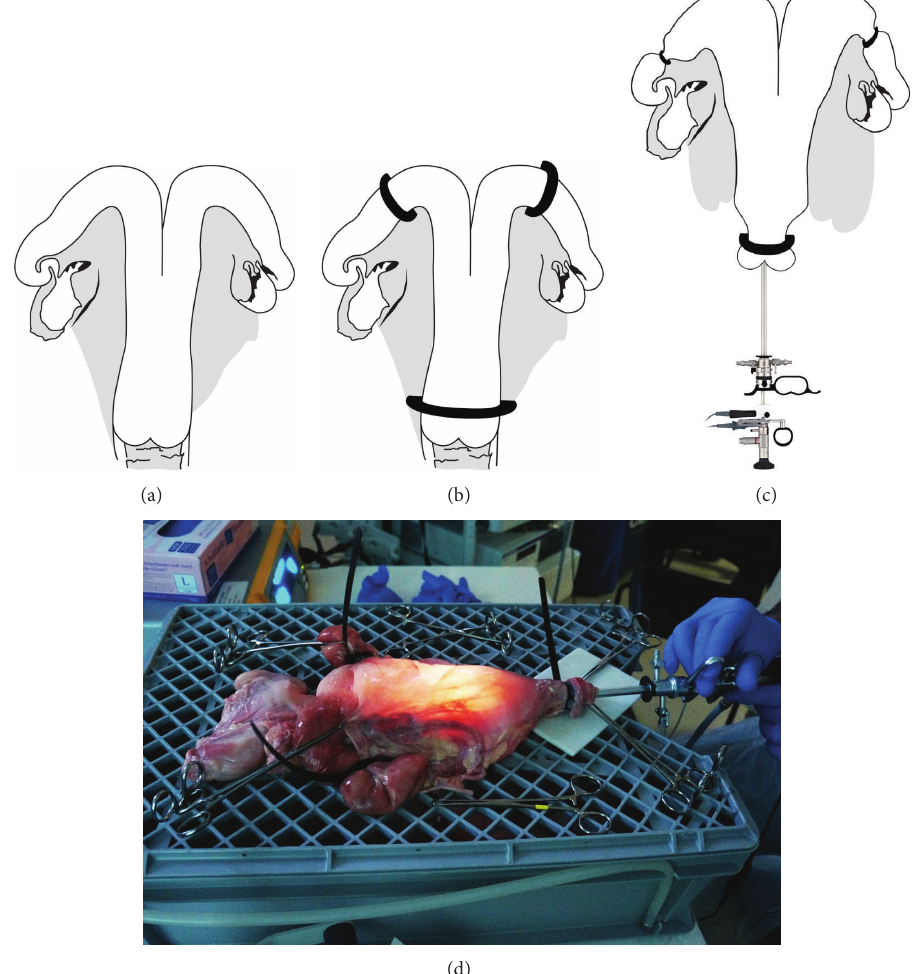
Figure 2: A diagram illustrating the shape of the cattle uterus and the site of placement of the 3 adjustable cable ties.